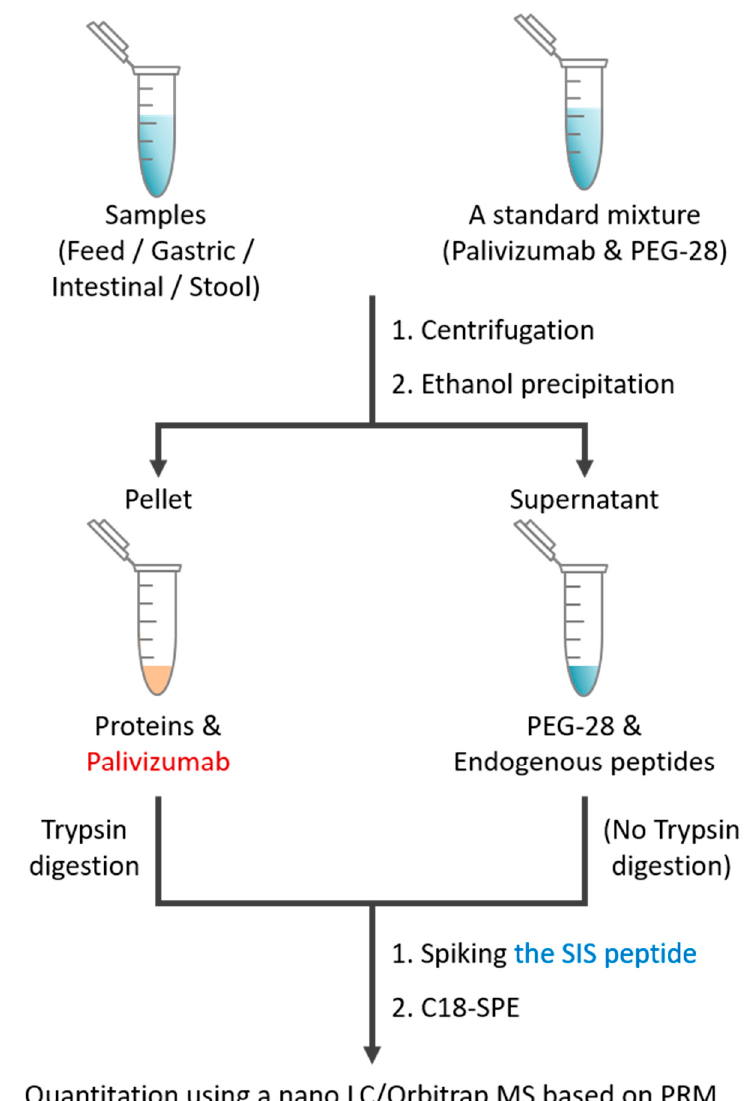
Figure 1. Experimental workflow for determining the concentration of palivizumab and PEG-28 in feed and digestive samples by PRM-based LC/MS analysis.